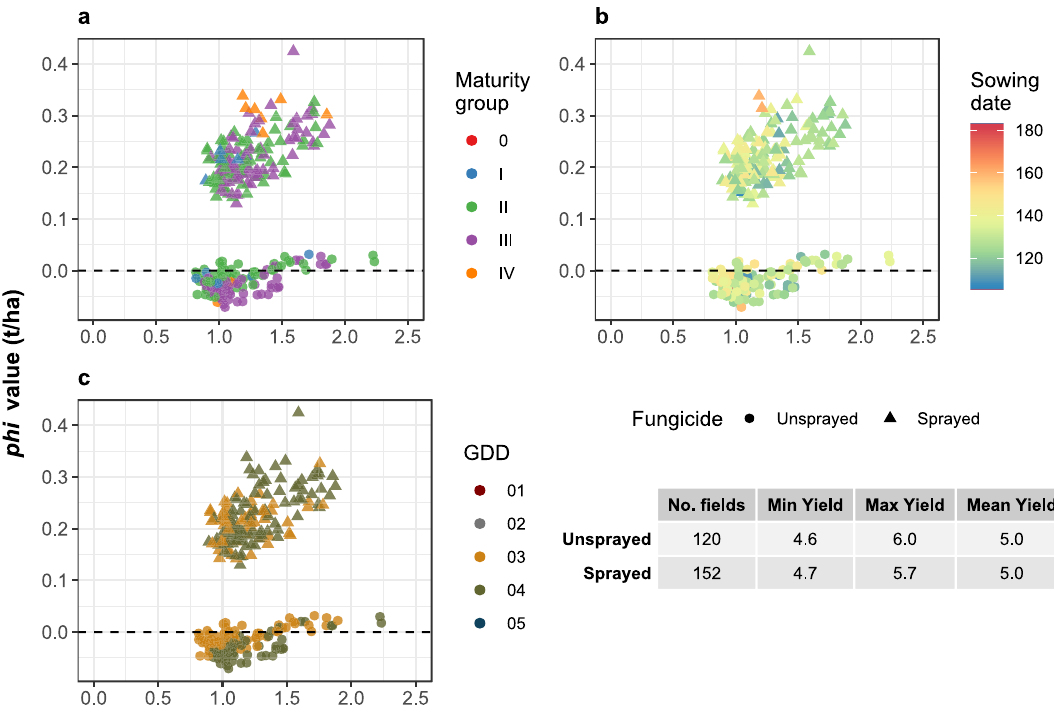
Figure 5. Shapley phi values attributed to foliar fungicides for two cohorts of high-yielding soybean fields: the 90th percentile for yield among fungicide-treated (sprayed) fields, and the 90th percentile for yield among unsprayed fields. Point shape indicates whether the field was treated with fungicides (Sprayed) or not (Unsprayed). Data points are colored by ( a ) soybean maturity group, ( b ) sowing date, as the number of days from Jan 01, ( c ) growing degree days (GDD), as defined in the TED construct. Five GDD categories were represented in the data, although only two of those (03, 04) were present in the cohorts plotted. 01 = 0 to 2670 °C; 02 = 2671 to 3169 °C; 03 = 3170 to 3791 °C; 04 = 3792 to 4829 °C; 05 = 4830 to 5949